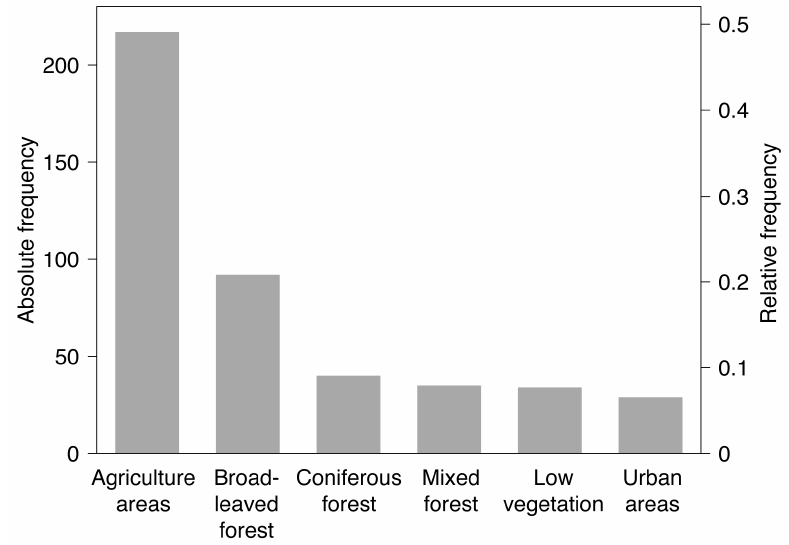
Figure 3. Frequency distribution of locations with tick-borne encephalitis virus detections in both ticks and endothermic mammals of the subsample used for the random forests model ( n = 447). Absolute frequencies depict the number of locations, relative frequencies the fraction of locations in the different land cover